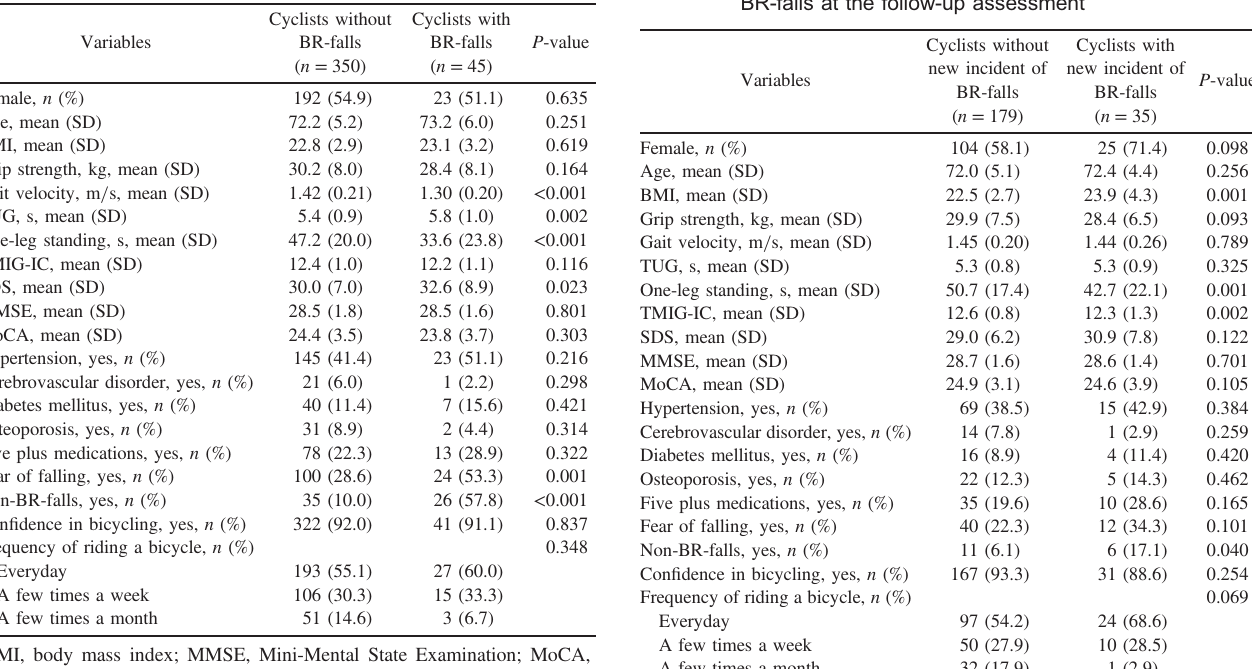
Table 1. Characteristics and di ff erences in measurements of cyclists with and without bicycle-related falls (BR-falls) at baseline Variables Female, n (%)